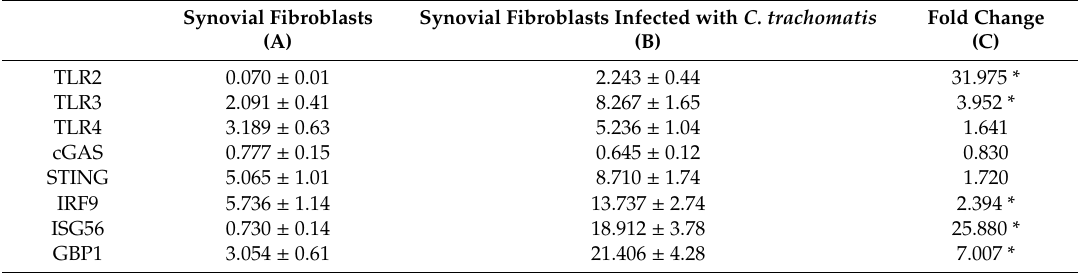
Table 1. Expression of pattern recognition receptors (PRRs) and IFN stimulated genes (ISGs) in human synovial fibroblasts after C. trachomatis